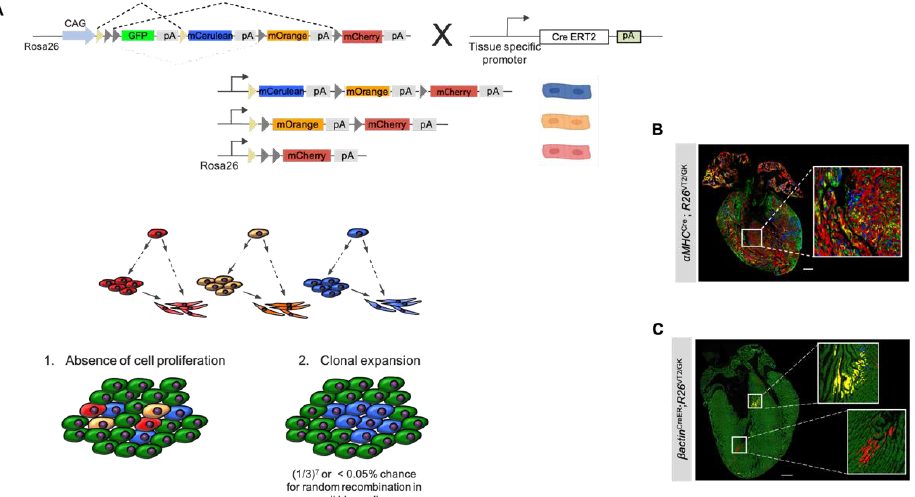
Figure 4. Clonal expansion of labeled cardiac cells using rainbow: ( A ) schematic representation of the rainbow reporter system in a Cre/LoxP transgenic mouse and diagram illustrating the difference between the absence and presence of clonal expansion in a population of rainbow-labeled cells; ( B ) Fluorescent light microscope image of an α MHC Cre ;R26 VT2/GK longitudinal mouse heart section at P1. Labeled α MHC -expressing cardiomyocytes exhibit single-cell clones of various colors, without obvious clusters representative of clonal expansion (scale bar 50 µ m) [38]; ( C ) fluorescent light microscope image of β actin CreER ;R26 VT2/GK E10.5 heart. Clonal expansion was observed in β actin-expressing labeled cells, shown in outlined yellow and red clustered segments (scale bar 100 µ m)